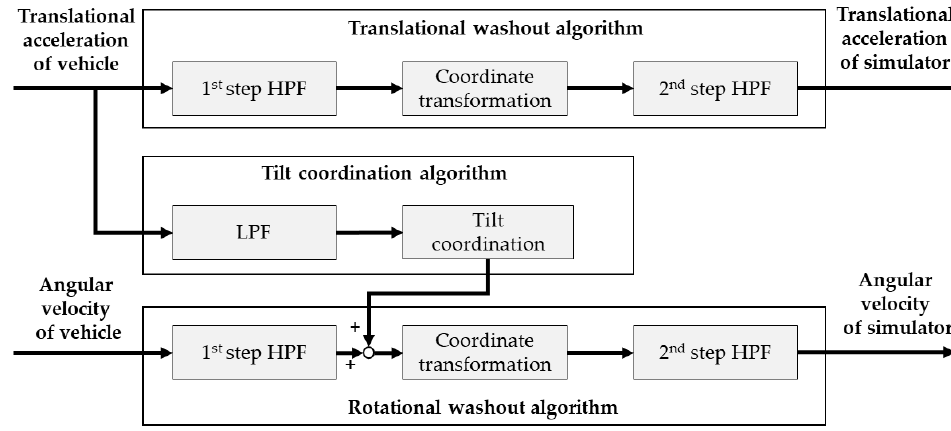
Figure 1. Structure of the classical washout